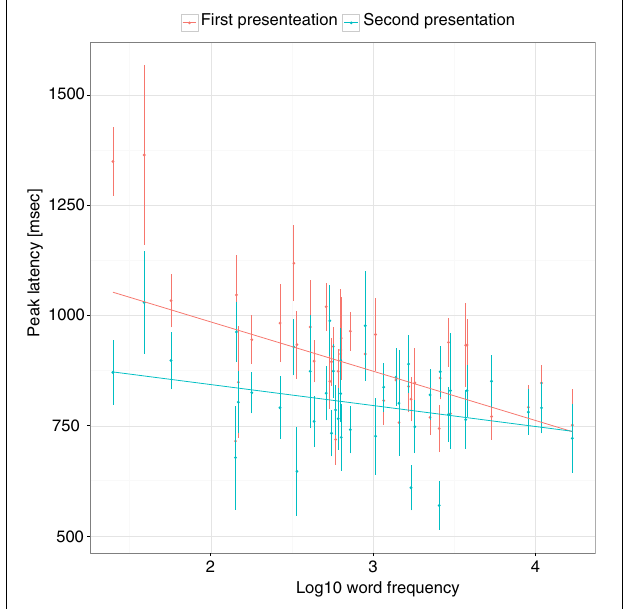
FIGURE 3 | Peak latencies as a function of lexical frequency and language status. Vertical lines and dots show the mean and standard error of individual items. Regression lines show the best fit for each group.